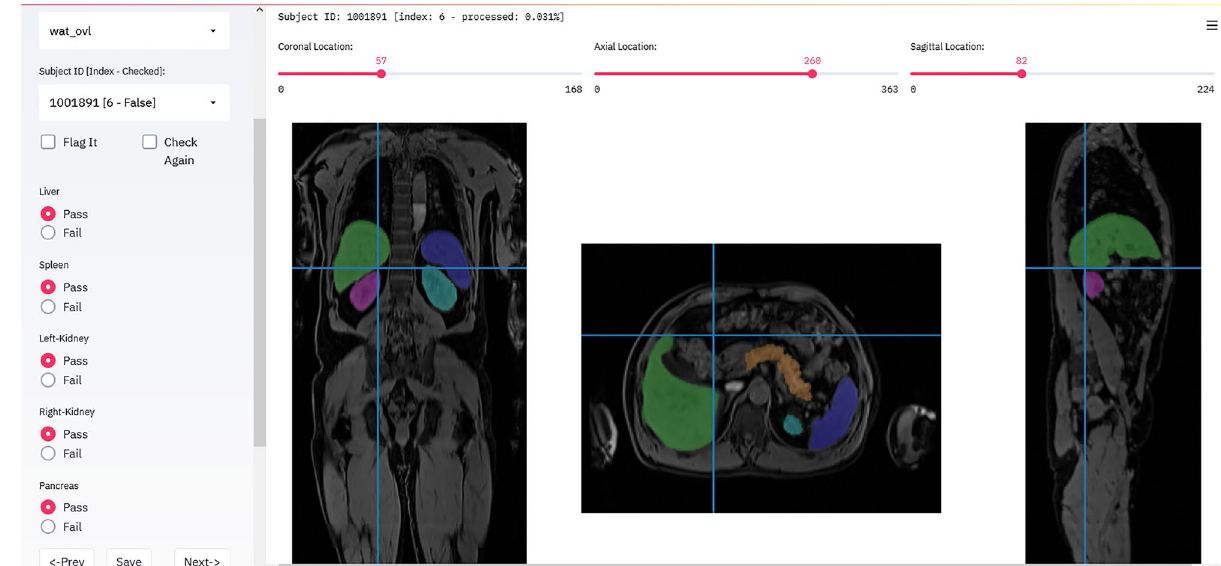
Figure 4. Quality analysis tool (SegQC). It enables visual assessment of segmentation quality by an expert in an efficient and scalable setup, specifically designed for population imaging studies with flexible caching and indexing to simplify the QC